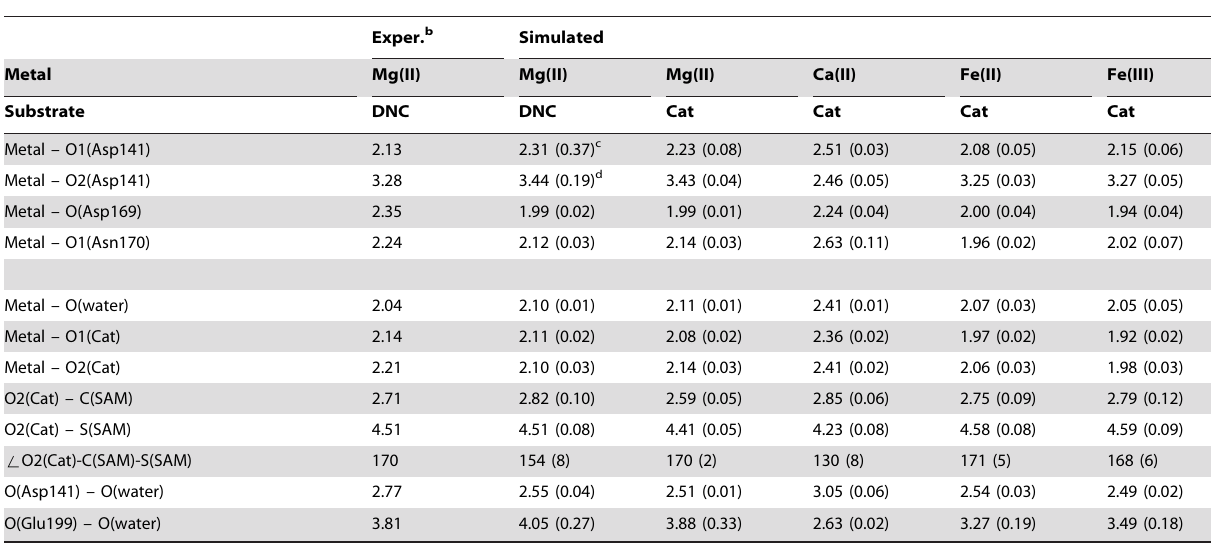
Table 1. Averaged structural parameters a characteristic of the active site of COMT as function of the bound metal cation and the substrate: 3,5-dinitrocatechol (DNC), or catechol (Cat). Experimental values for Mg-COMT/3,5-dinitrocatechol are shown for comparison.